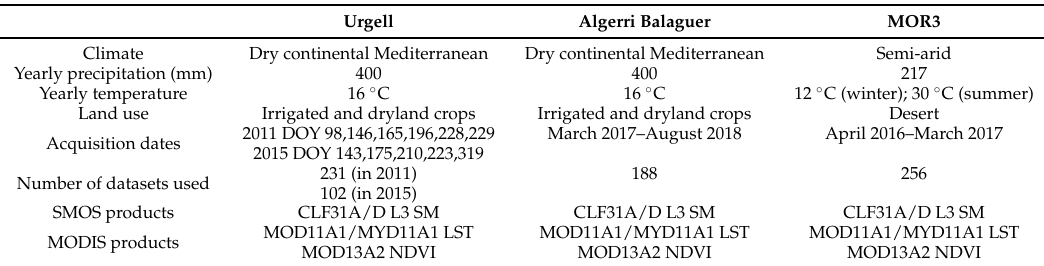
Table 1. Summary of in situ areas characteristics, alongside the acquisition days/periods, number of datasets used and corresponding satellite data